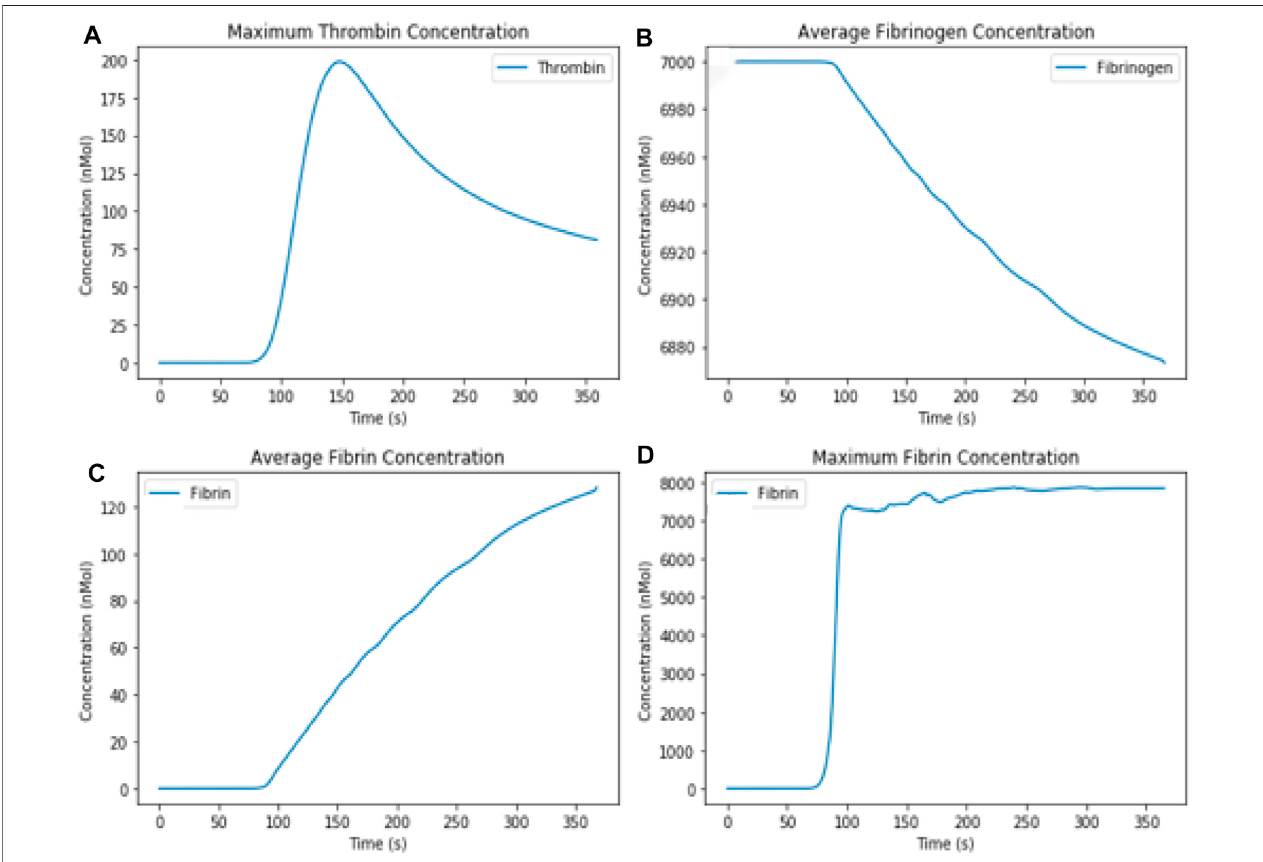
FIGURE 6 | Maximum strain rate value before and after clot initiation in the three-dimensional model.